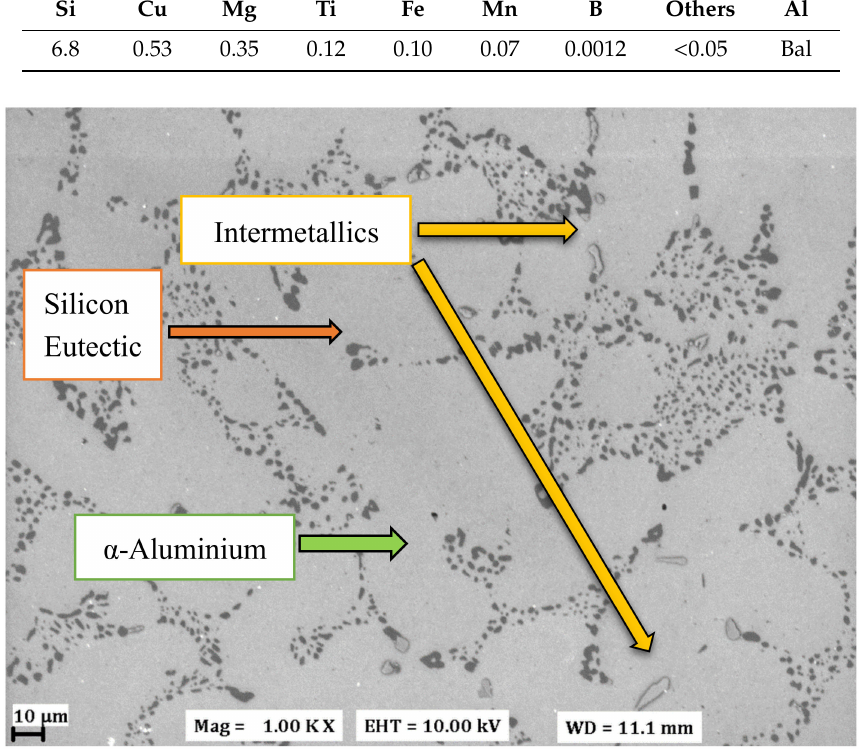
Figure 1. Electron micrograph of the tested cast A356-T7 + 0.5 wt.% Cu alloy.